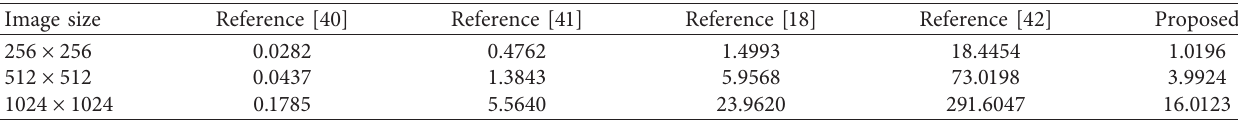
Table 12: Time complexity analysis (second).